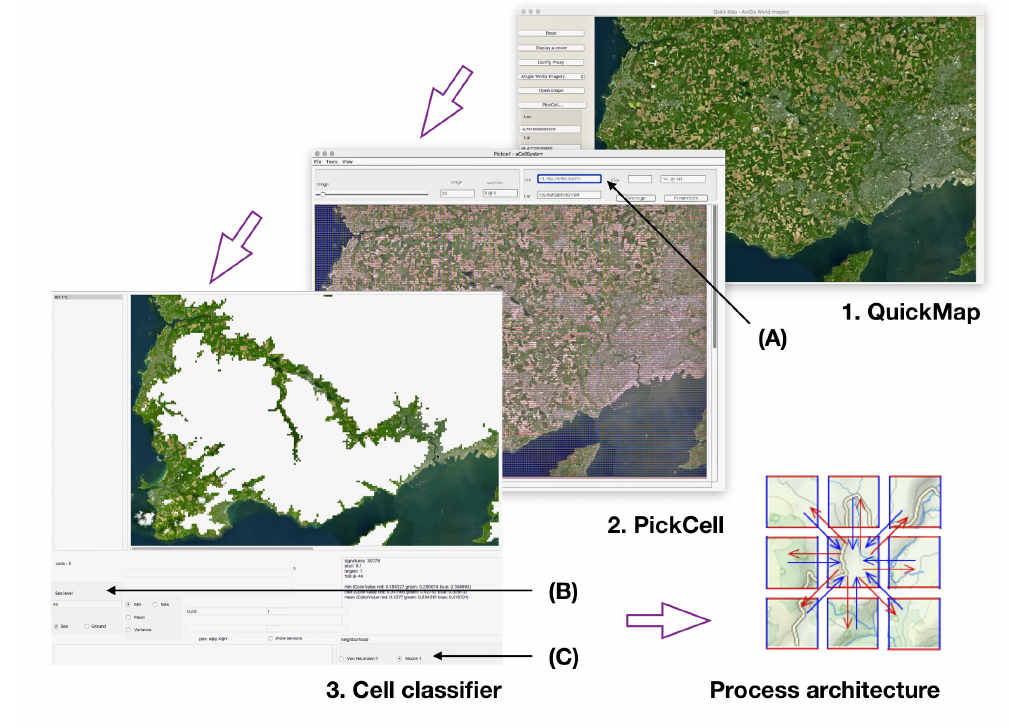
Figure 11. Cell synthesis flow: (1) a zone was located from a Quickmap navigation, and (2) was segmented into cells, then a subsystem was extracted filtering cells with elevations less than 45 m. (3) A cell system was generated following Moore topology. Annotations show controls for geographical positions with a cell size of 5 × 5 pixels representing a 191 × 191 m 2 surface ( A ), classification was operated for elevation ( B ). The neighborhood was Moore, radius 1 ( C